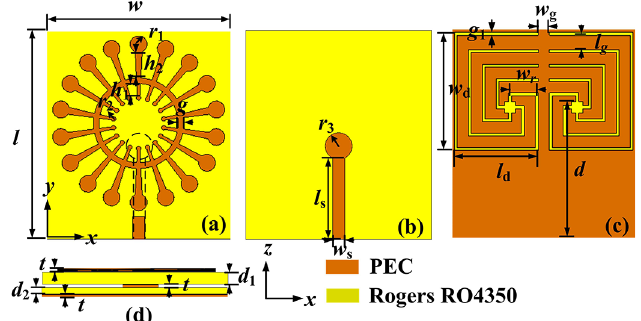
Fig. 1. (a) Top metallic layer, (b) middle metallic layer, (c) bottom metallic layer, and (d) side view of the antenna. Dimensions: l =37mm, w =33mm, h 1 =2.5, h 2 =6mm, g =1mm, l s =14.34mm, w s =2.1mm, r 1 =1.5mm, r 2 =0.4mm, l d =15mm, w d =20.5mm, g 1 =0.5mm, w g =2mm, l g =2.5mm, w r =5.25mm, d =24mm, d 1 =2.03mm, d 2 =1.01mm, and